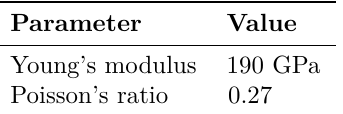
Table 1. Parameters of material model